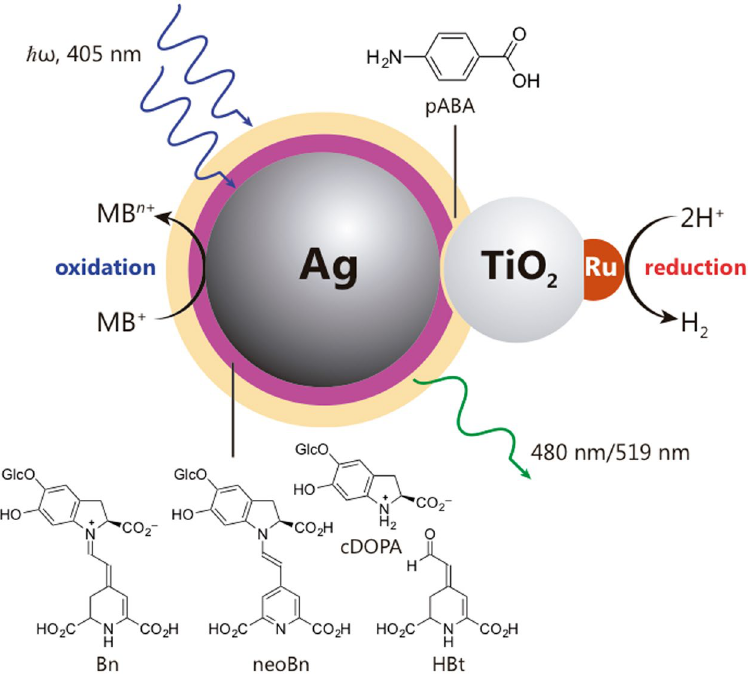
Figure 1. Nano-hybrid assembly synthesized using modular design approach. The architecture is comprised of light absorber and oxidation catalyst (Ag NPs), a molecular wire linker (pABA), a semiconductor (TiO 2 ), a co- catalyst (Ru NPs) and regenerators